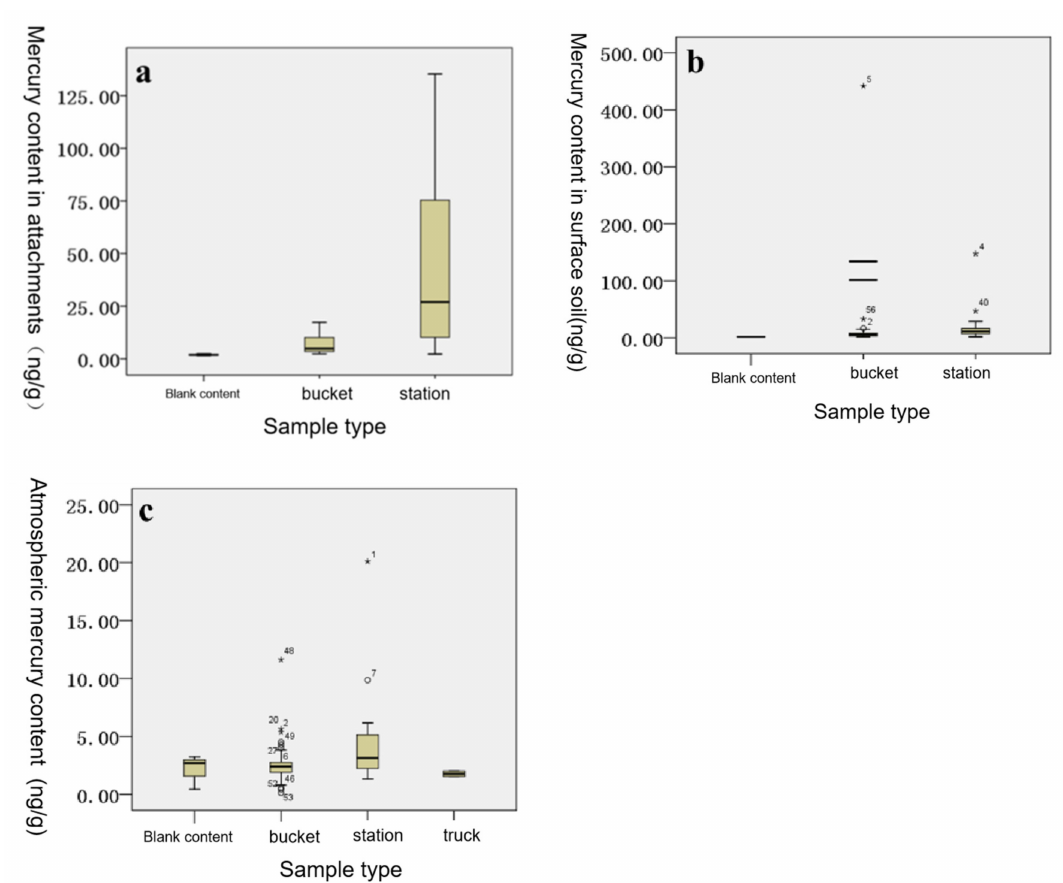
Figure 9. ( a ) Mercury content levels of the various types of attachments at different collection points. ( b ) Surface soil mercury content levels. ( c ) Atmospheric mercury content levels. “*” means extreme outlier.